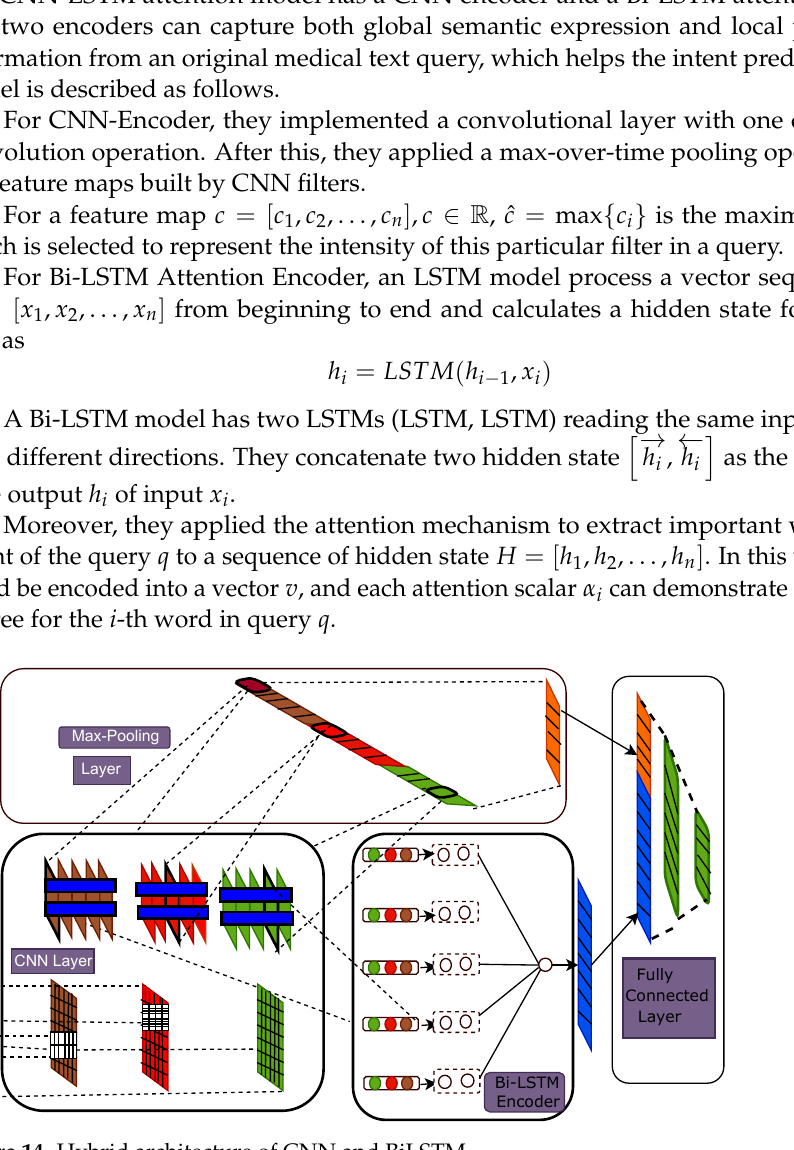
Figure 14. Hybrid architecture of CNN and